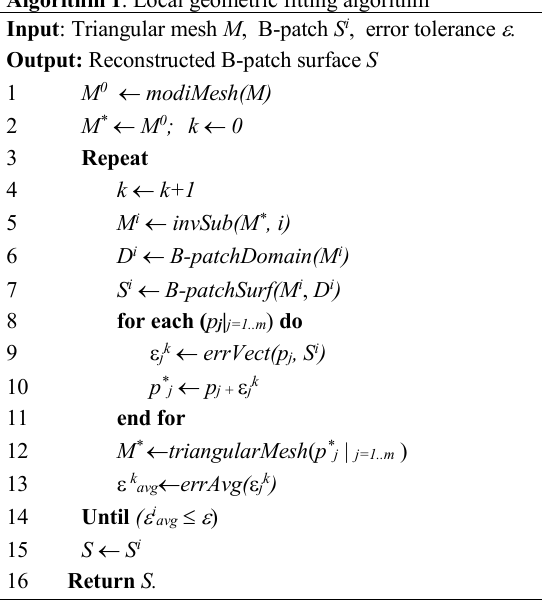
Algorithm 1 . Local geometric fitting